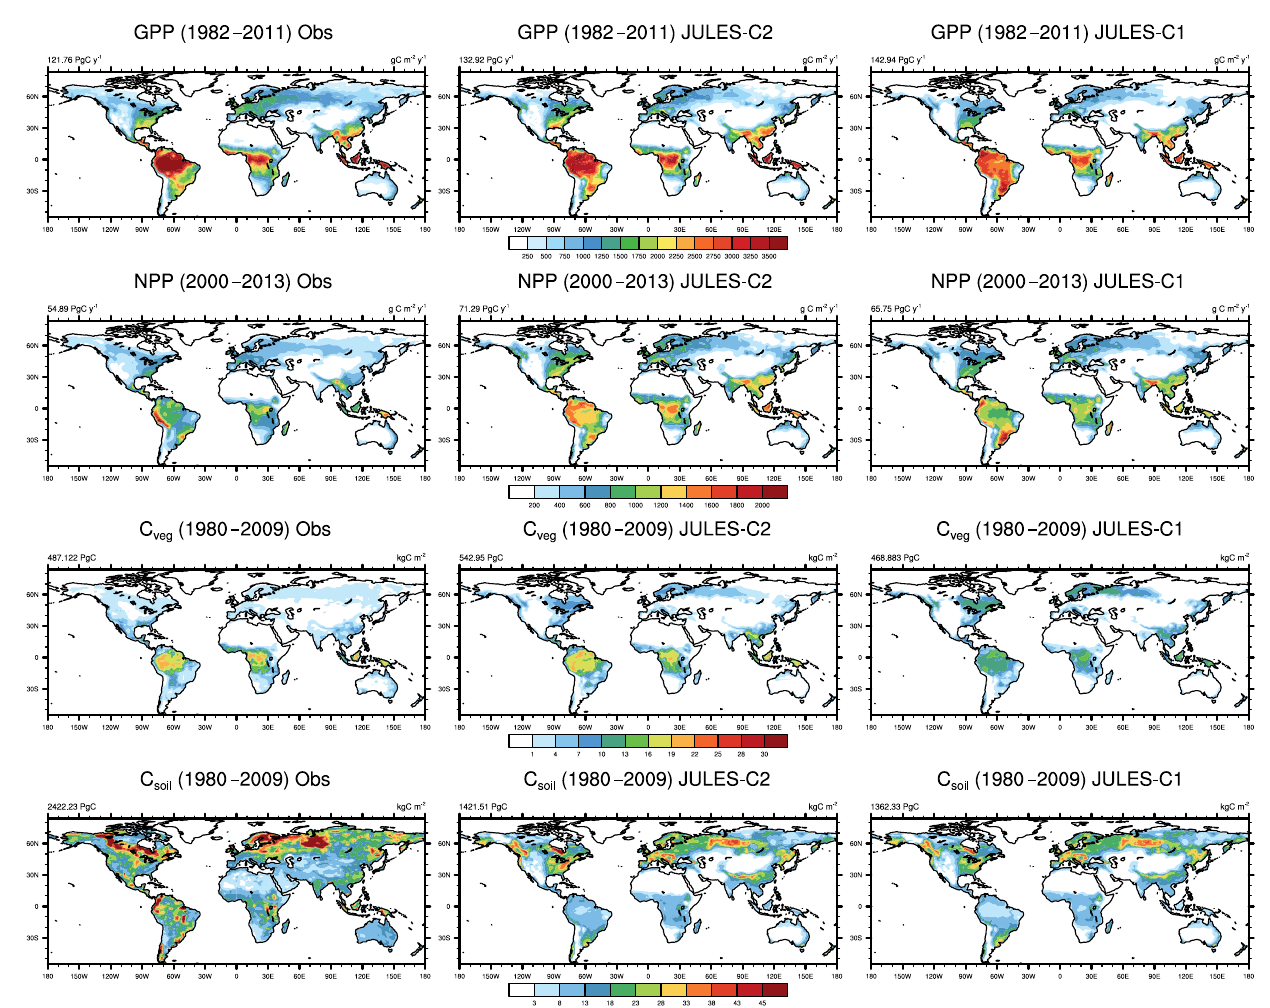
Figure 4. Simulated and observed GPP, NPP, and vegetation and soil carbon. Results are shown from JULES-C2 and JULES-C1 both with CRUNCEP-v6 climate. Sources for observations are as follows: GPP from FLUXNET derived model tree ensemble (Jung et al., 2011); NPP from MODIS17 (Zhao et al., 2005); C veg from Ruesch and Gibbs (2008); and C soil from Carvalhais et al.